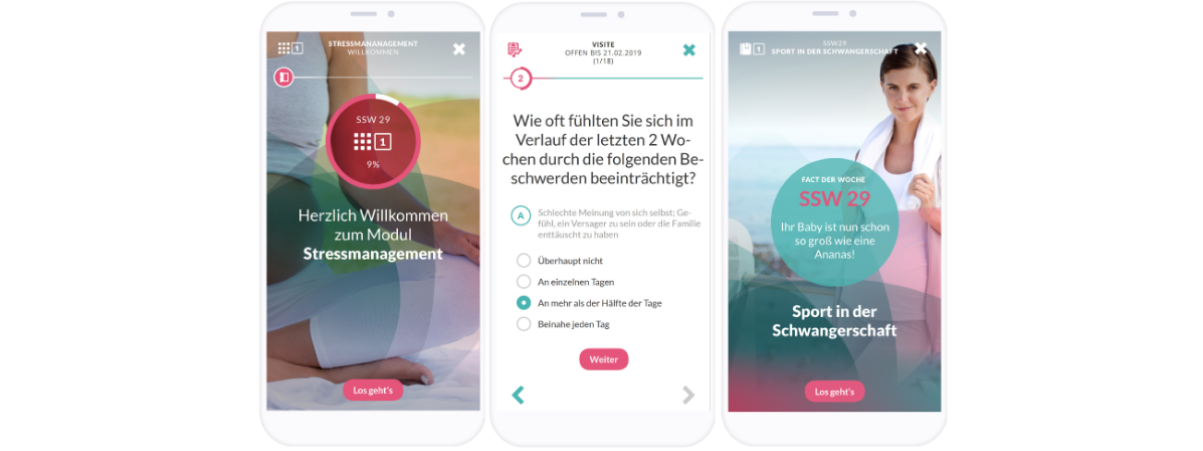
Figure 1. Screenshots of the electronic mindfulness-based intervention app. The first screen shows the home screen, the second screen shows the electronic assessment of the patient reported outcomes, and the third screen shows the digital pregnancy